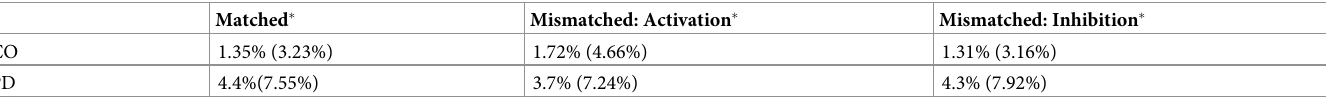
Table 3. Error rate for control, activation, and inhibition trials. Values are mean percentages (SD), calculated by number of incorrect trials / number of total trials. � p < .05. Matched